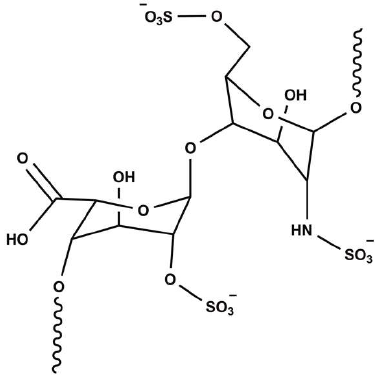
Figure 1. SEM images of ( a ) ZIF-67 (8000×) and ( b ) ZIF-8 (18,000×) nanomaterials.